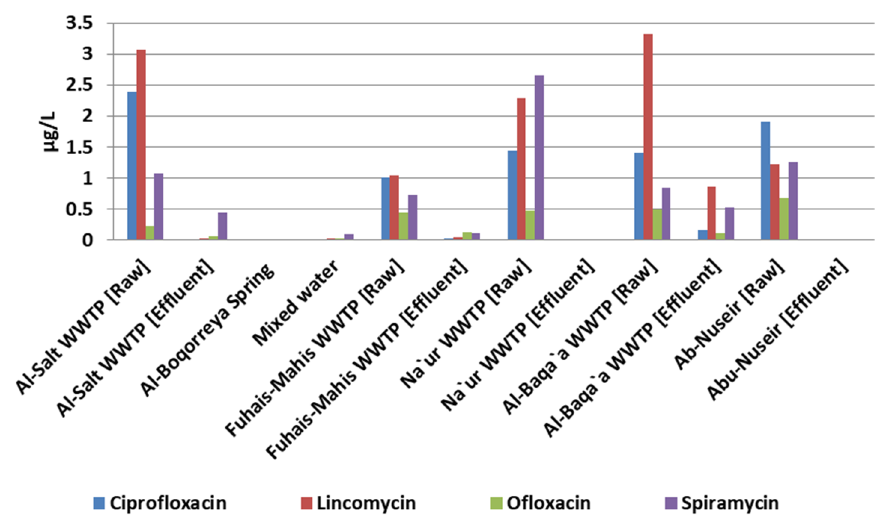
Figure 3. Concentration of lincomycin, ciprofloxacin, ofloxacin, and spiramycin in the investigated water samples.